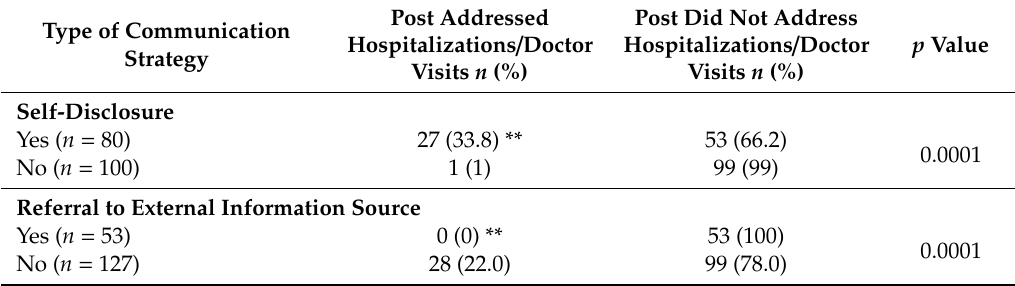
Table 6. Frequency of communication strategies used in COPD Facebook group wall posts based on whether or not post addressed hospitalizations / doctor visits ( n =